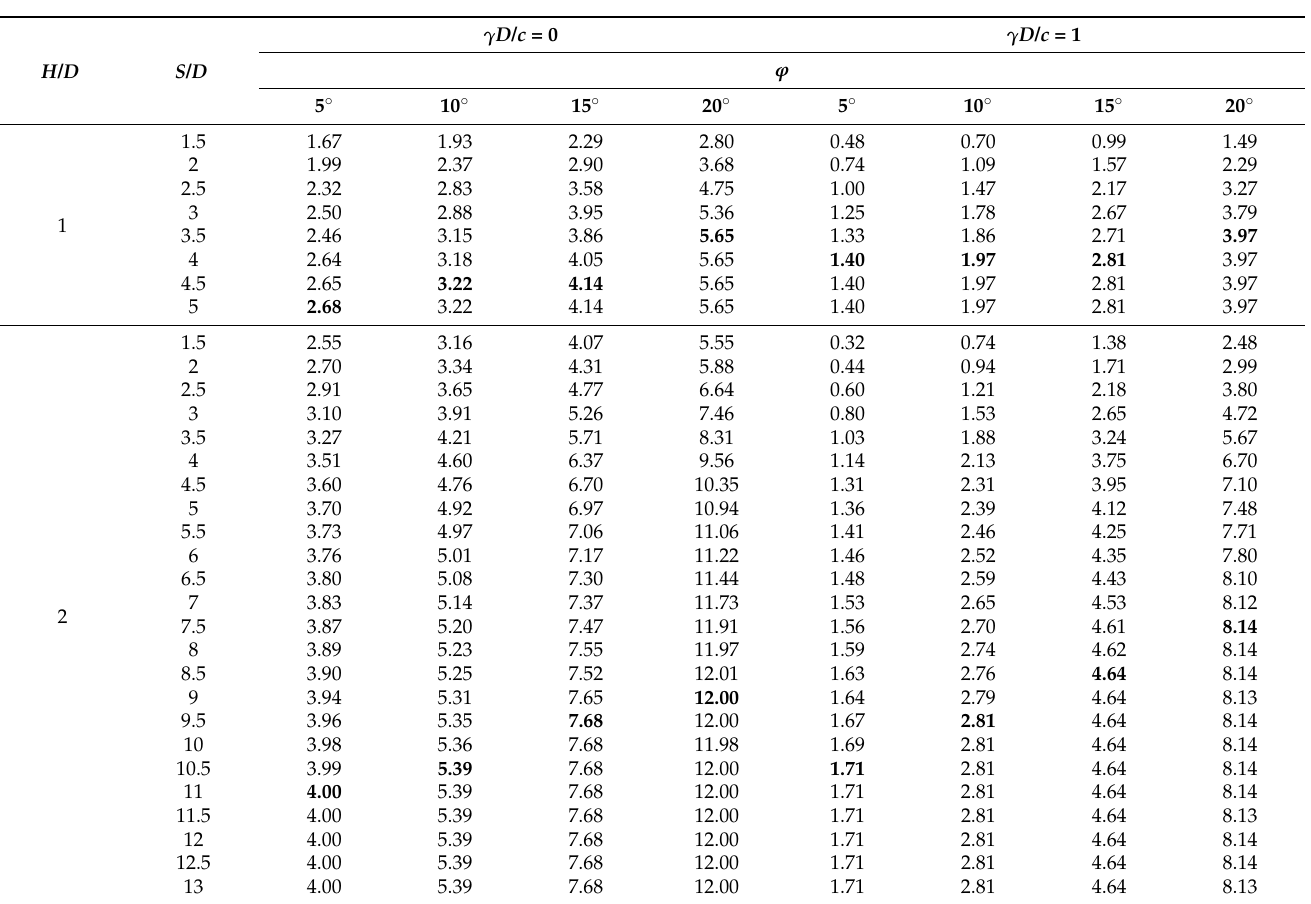
Table 4. Seismic bearing capacity N cs with k h =